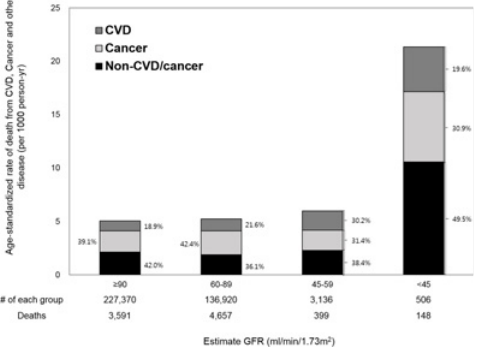
Fig 1. Age-standardized mortality rate (per 1000 person-years) by